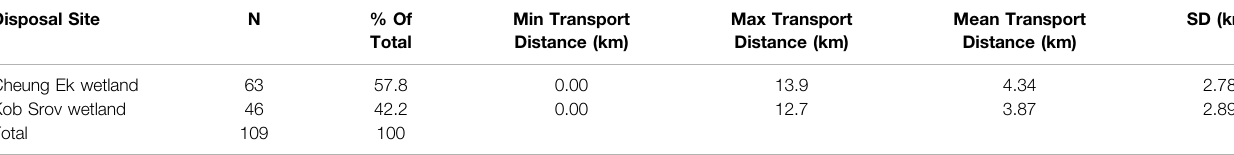
TABLE 2 | Summary statistics on fi nal disposal sites of faecal sludge on Phnom Penh ( N = number of samples, SD = standard deviation). Disposal Site